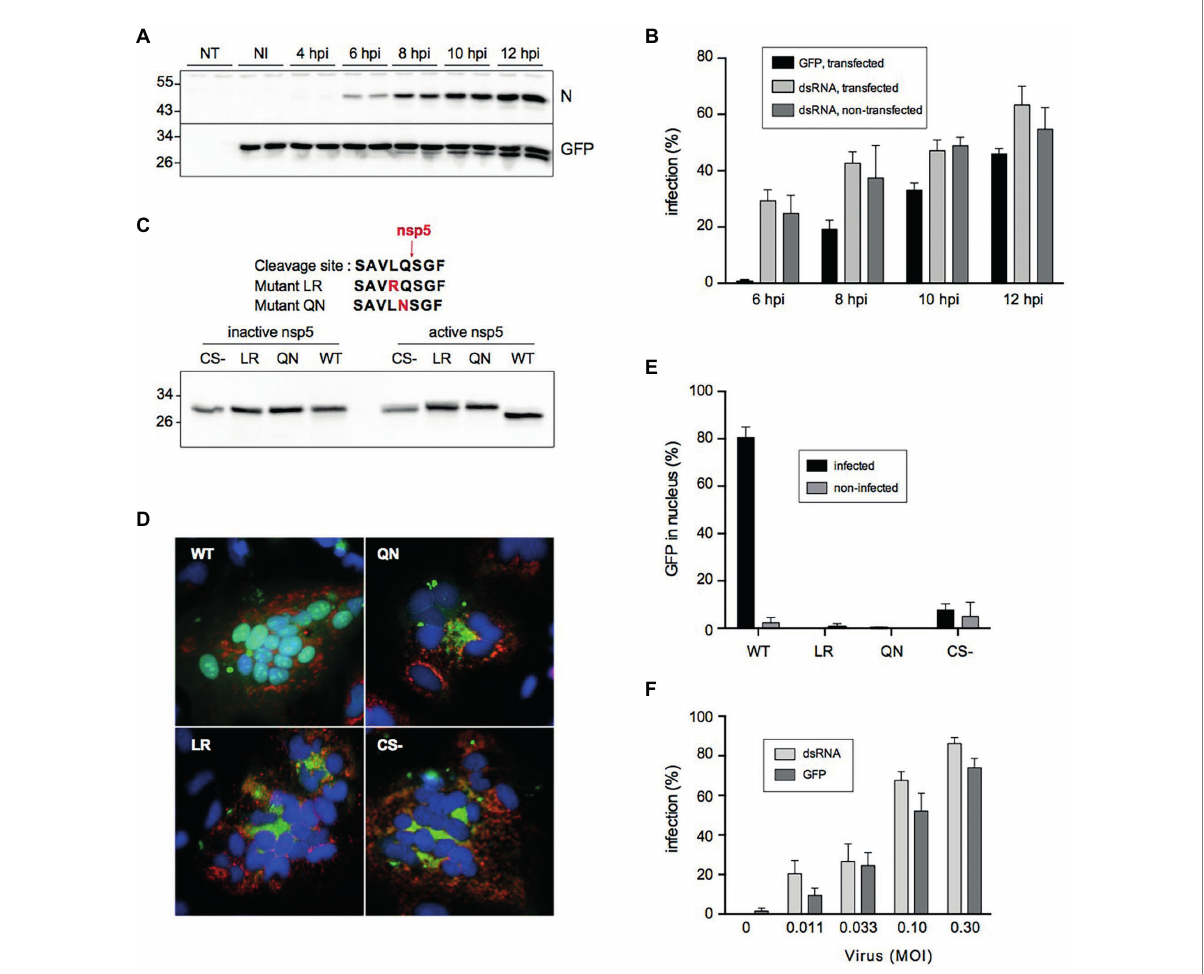
FIGURE 3 Cleavage of the fluorescent reporter in SARS-CoV-2-infected cells. (A) Kinetics of cleavage analyzed by immunoblotting. NT: non-transfected, NI: non-infected, N: nucleocapsid, GFP: fluorescent reporter detected with an antibody to GFP. (B) Kinetics of infection quantified by nuclear translocation (GFP) in cells transfected with the fluorescent reporter and by dsRNA immunostaining in transfected or non-transfected cells (mean ± SD of 6 replicates). (C) Impact of mutating Leu and Gln residues on the cleavage by SARS-CoV-2 nsp5. The amino acid sequences of the mutant cleavage sites are shown on top. HeLa cells were co-transfected with indicated constructs and an active or inactive version of nsp5 and analyzed by immunoblotting with an antibody to GFP. CS- is a construct lacking the whole cleavage site peptide. (D) Impact of cleavage site mutation on nuclear transfer of the reporter. HeLa cells were co-transfected with indicated constructs (green) and a plasmid expressing human ACE2 and infected with SARS-CoV-2. Cells were fixed and processed for immunofluorescent detection of dsRNA (red) and DAPI staining (blue) at 16 hpi. (E) Impact of cleavage site mutation on nuclear transfer of the reporter in Vero cells. Vero-81-derived clone 6 cells were transfected with indicated constructs and infected with SARS-CoV-2. Infected cells were defined by dsRNA immunostaining and the nuclear localization of GFP in infected and non-infected cells was quantified (mean ± SEM of 4 independent experiments). (F) Nuclear GFP staining as a function of virus input. The infection was measured by counting cells GFP staining (GFP) or by immunostaining to dsRNA (mean ± SD of 8